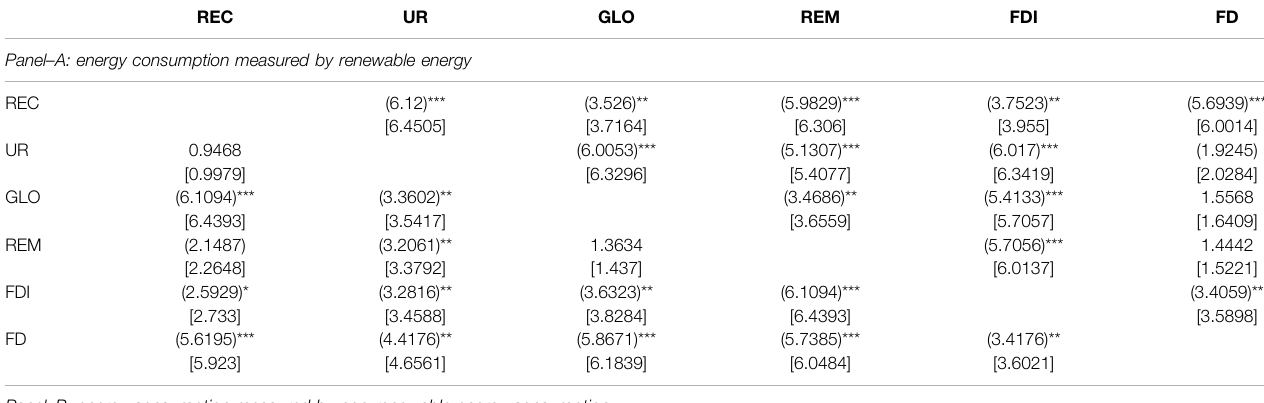
TABLE 7 | Results of Dumitrescu – Hurlin (DH) panel causality test.